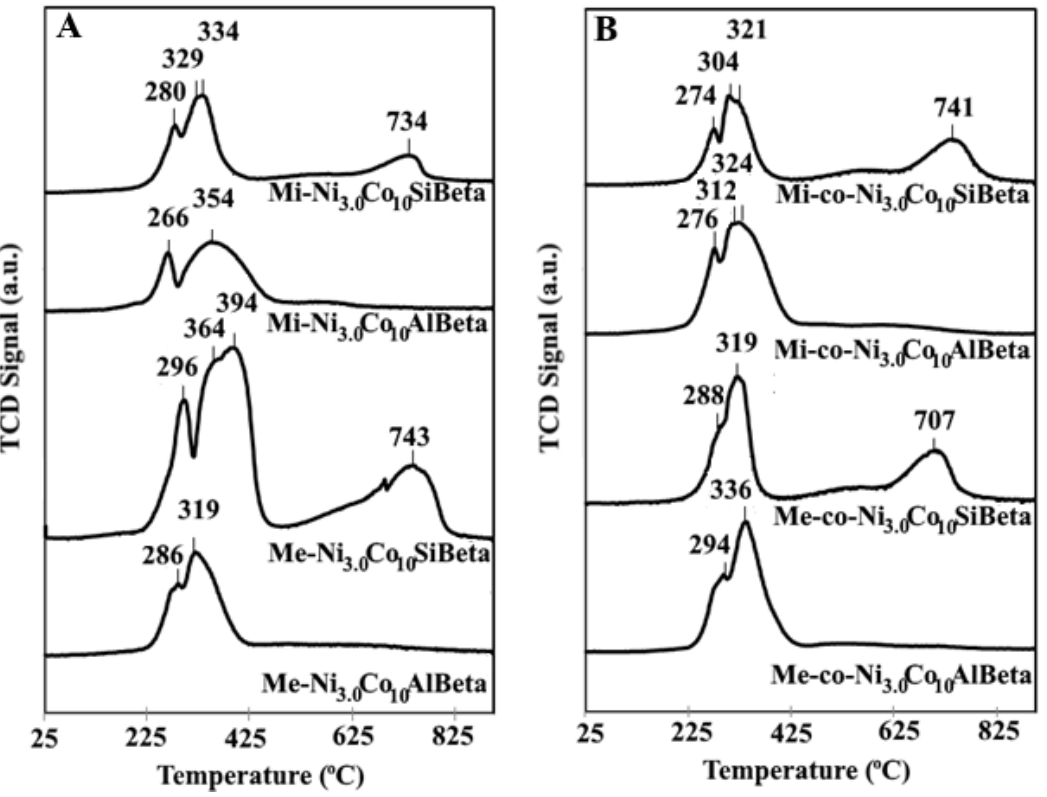
Figure 6. TPR-H 2 profiles of ( A ) Me-Ni 3.0 Co 10 Beta, Mi-Ni 3.0 Co 10 Beta and ( B ) Me-co-Ni 3.0 Co 10 Beta, Mi-co-Ni 3.0 Co 10 Beta.